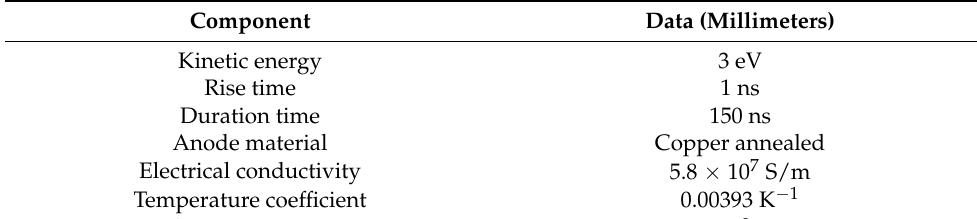
Table 4. The initial conditions of the simulation by Particle-In-Cell.